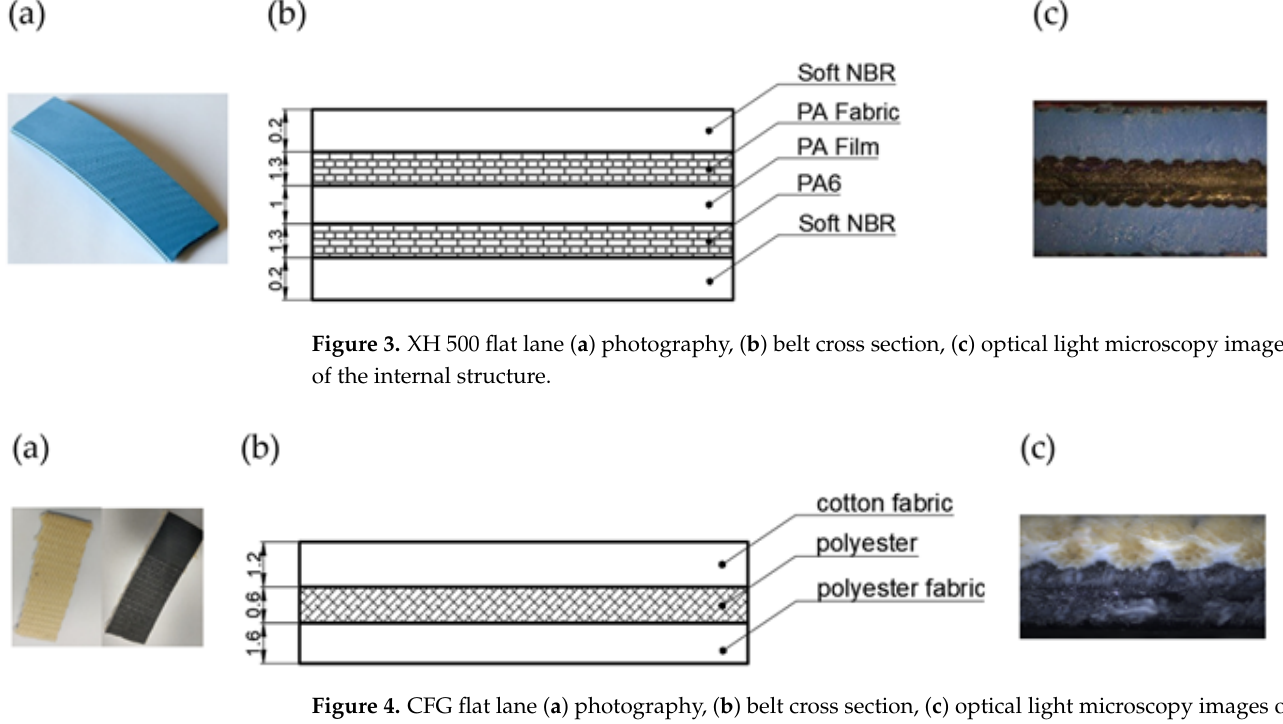
Figure 4. CFG flat lane ( a ) photography, ( b ) belt cross section, ( c ) optical light microscopy images of the internal